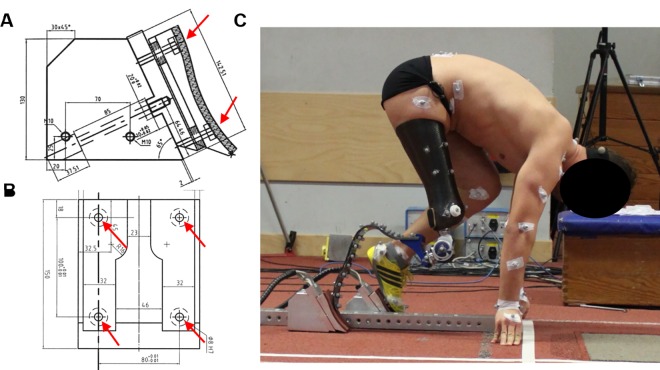
Instrumented starting blocks used in the study.A and B show schematic drawings of the blocks (including four 3D piezo-type force sensors marked by red arrows) from the side (A) and from the front (B). In C, one of the unilateral transfemoral amputees is shown in the set position.